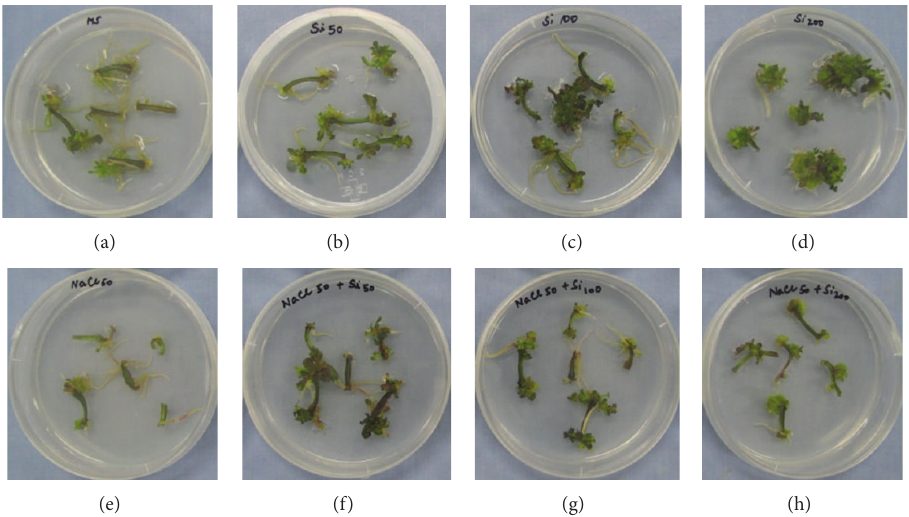
Figure 2: Effect of silicon and NaCl on adventitious shoot regeneration from leaf explants of A. multiflora . (a) MS medium with 12.2 𝜇 M 2iP and 5.7 𝜇 M IAA (SIM), (b) SIM + 1.8 mM Si, (c) SIM + 3.6 mM Si, (d) SIM + 7.2 mM Si, (e) SIM + 50 mM NaCl, (f) SIM + 50mM NaCl